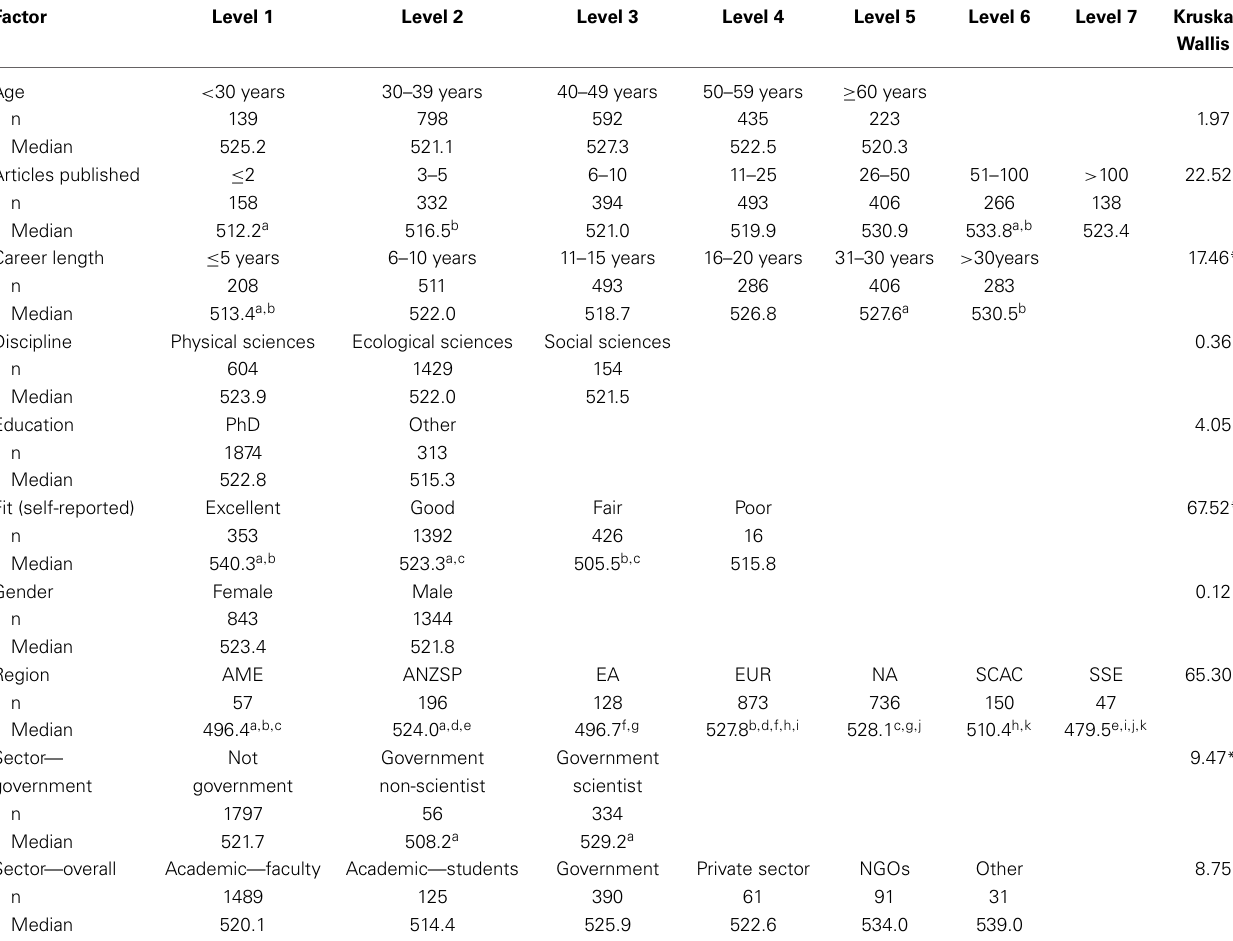
Table 3 | Differences in median fitness score for respondents belonging to different demographic and professional